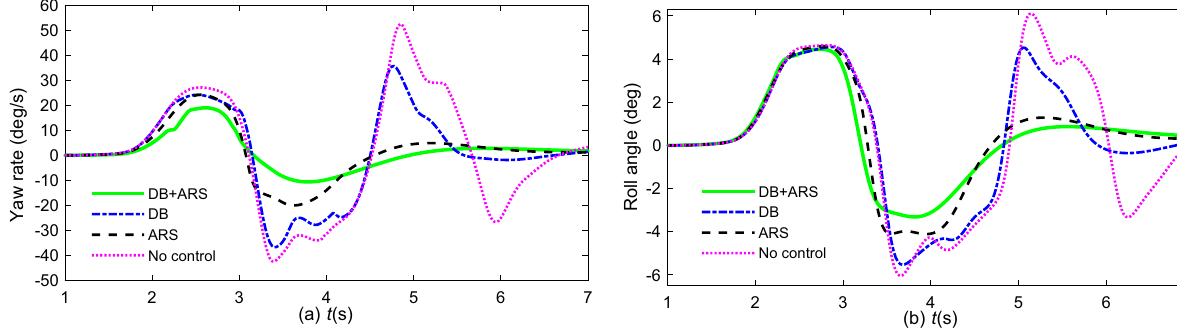
Figure 21. Vehicle driving stability: ( a ) yaw rate; ( b ) roll angle.